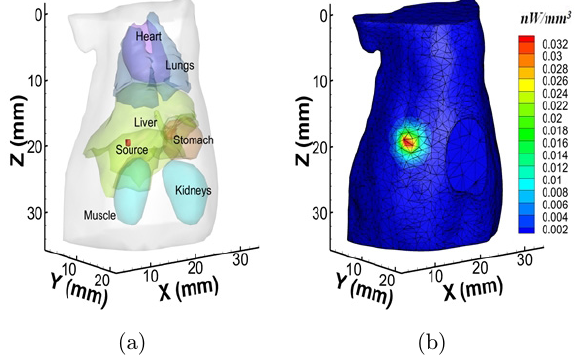
Fig. 2. (a) The torso of the mouse atlas model with a cylin- drical source in the liver, (b) forward mesh and the simulated photon distribution on the surface.